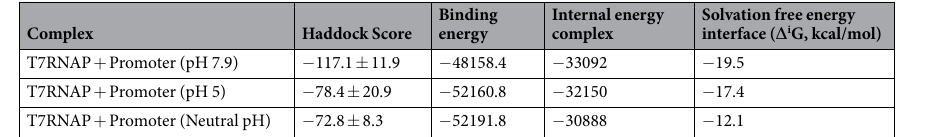
Table 2. HADDOCK docking results for the complexes of T7RNAP at different pH and T7 promoter. The HADDOCK scores are in arbitrary units (a.u.). Solvation free energy interface calculated using